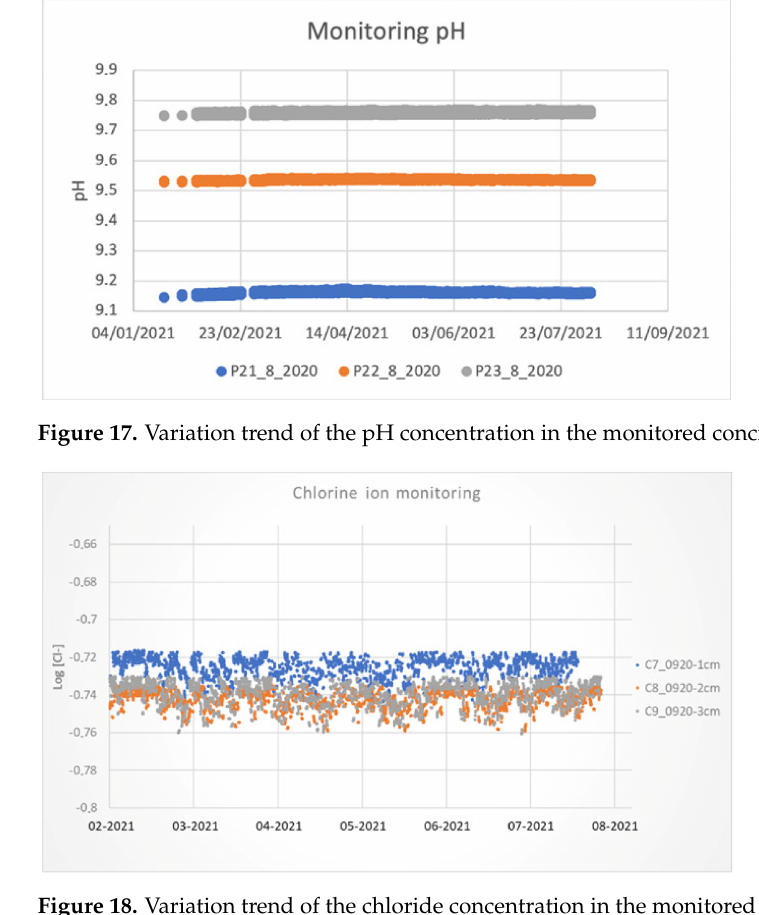
Figure 18. Variation trend of the chloride concentration in the monitored concrete